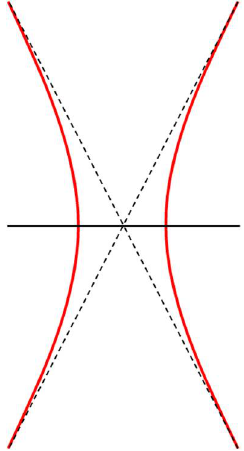
Figure 2. Schematic of Gaussian beam profile used in LA-LBMM process.